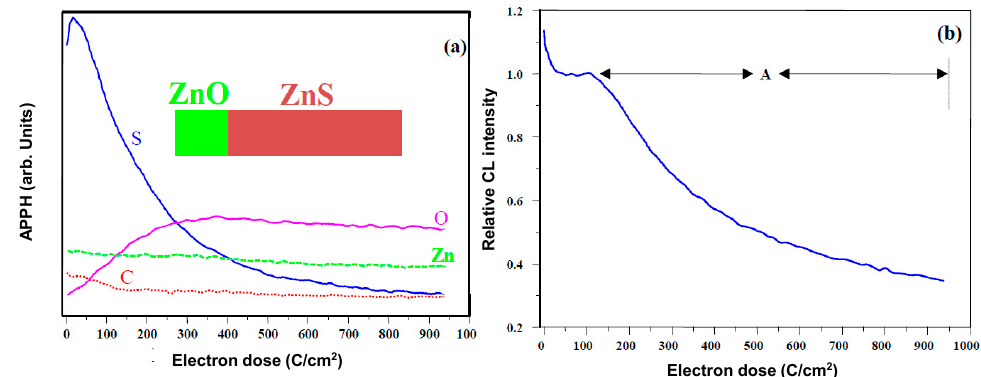
Figure 2. The ( a ) APPHs; and ( b ) CL intensity of ZnO during prolonged electron bombardment as function of electron dose [11].